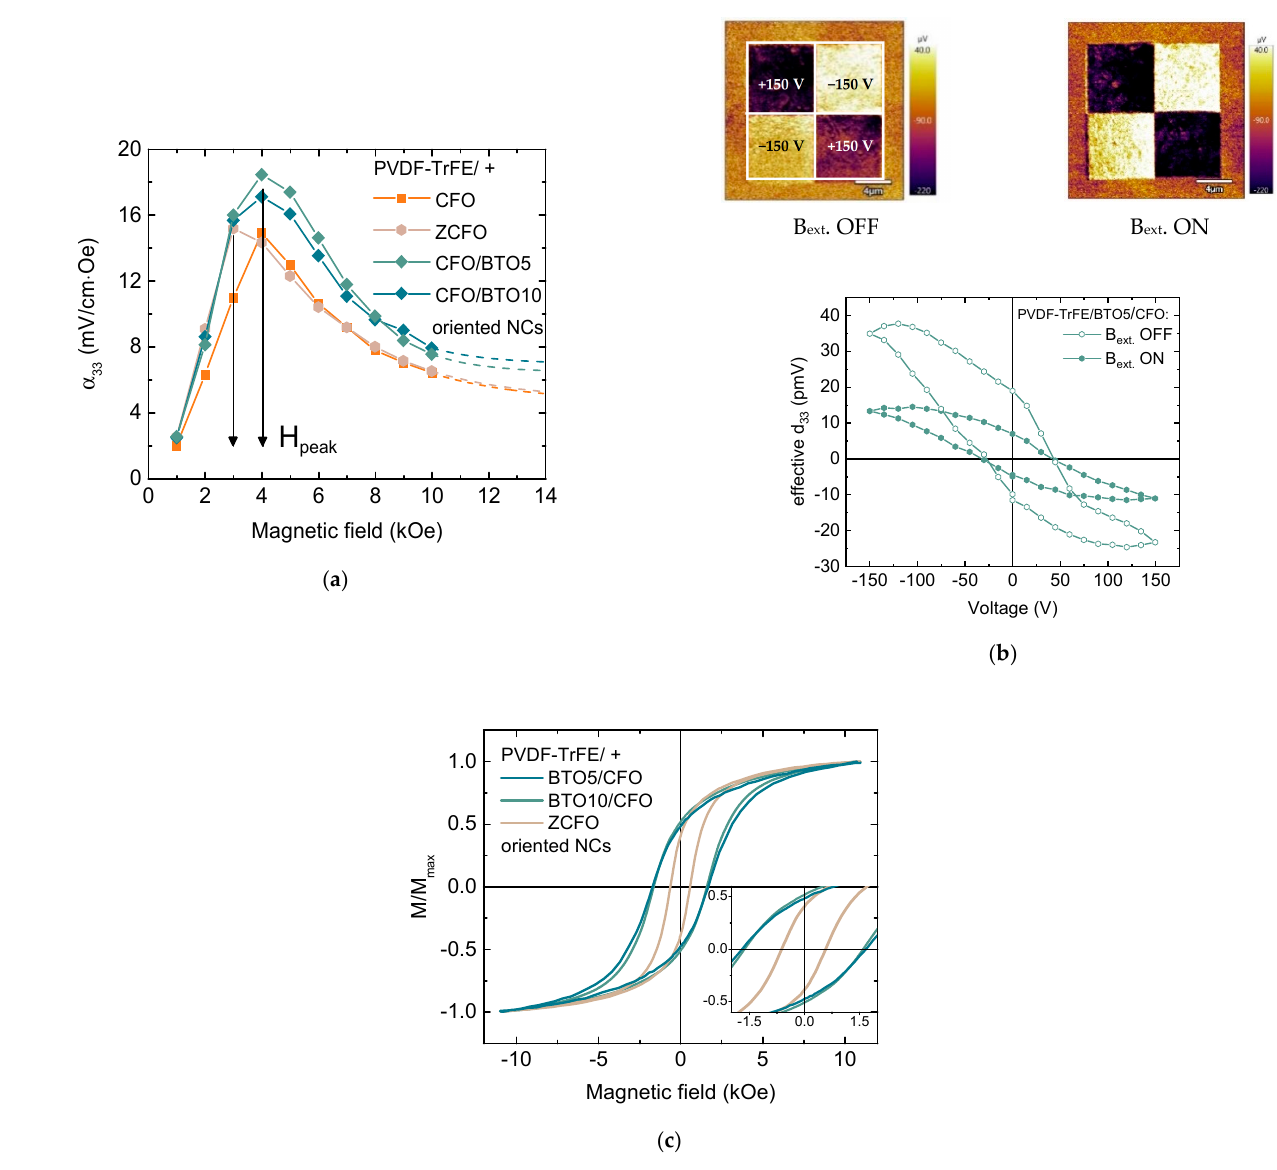
Figure 9. ( a ) Dependencies of the ME voltage coefficient ( α ME ) on DC bias magnetic field composites at AC field frequency of 10 kHz for PVDF-TrFE -based samples with ZCFO, BTO5/CFO and BTO10/CFO fillers (PVDF-TrFE/CFO is shown again for comparison); ( b ) piezoresponse force microscopy (PFM) images and remnant local piezoelectric hysteresis loops at applied and switched off the magnetic field (B ext. = 1.4 kOe) for PVDF-TrFE/BTO5/CFO sample; ( c ) M-H loops at 300 K for PVDF-TrFE/ZCFO, PVDF-TrFE/BTO5/CFO and PVDF-TrFE/BTO10/CFO